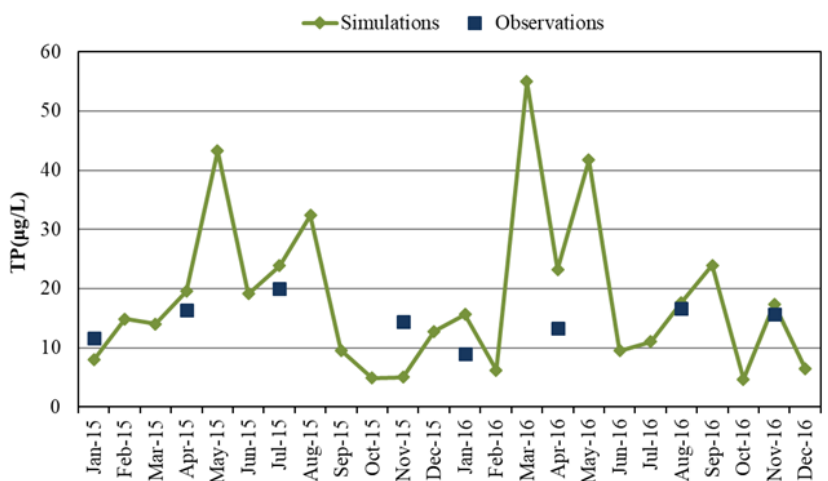
Figure 8. The model calibration (2015) and verification (2016) of the Vollenweider model TP simulations.